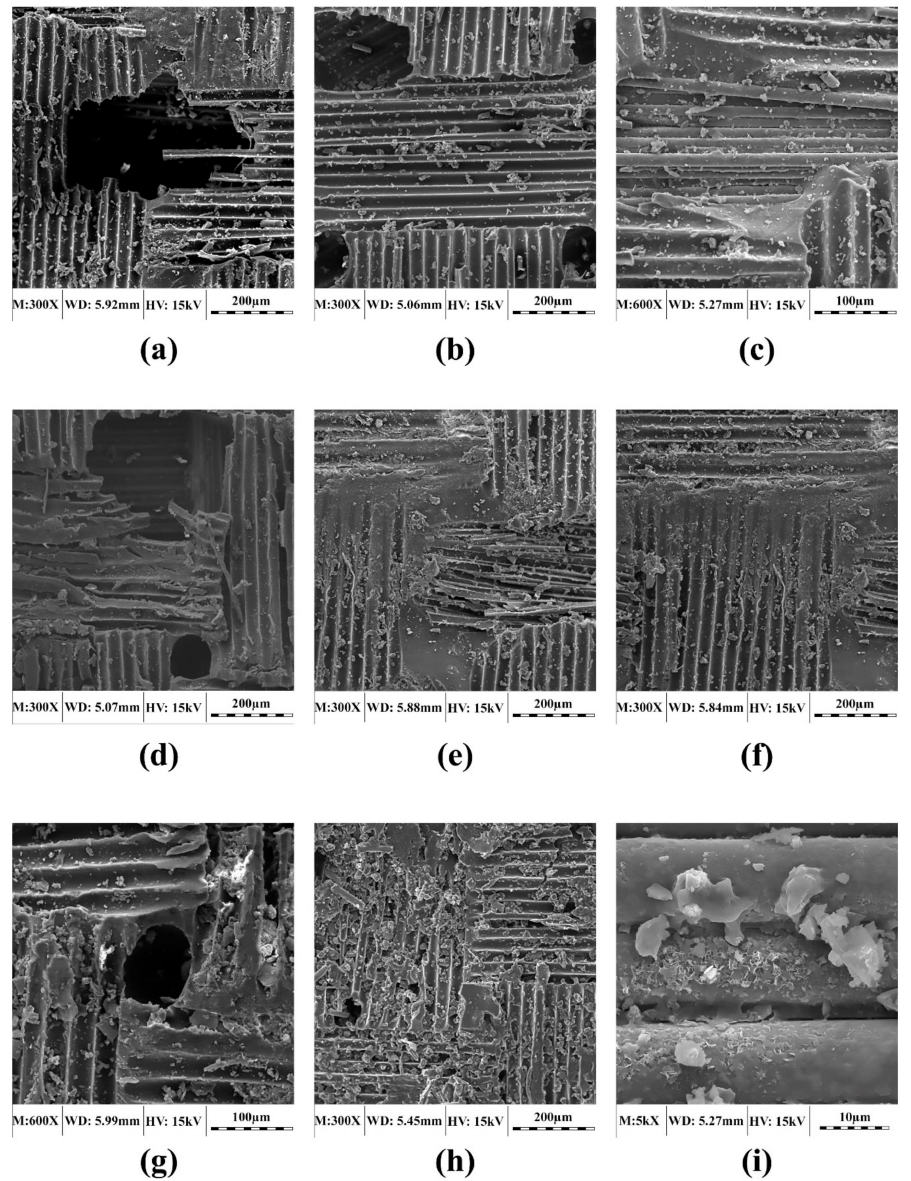
Figure 7. SEM micrographs of selected 2-mm laminates exposed to UV and water vapor condensation cycles: ( a ) UL exposed to 750-h cycles, ( b ) UL exposed to 1250-h cycles, ( c ) UL exposed to 2000-h cycles, ( d ) WL exposed to 750-h cycles, ( e ) WL exposed to 1250-h cycles, ( f ) WL exposed to 2000-h cycles, ( g ) RL exposed to 750-h cycles, ( h ) RL exposed to 1250-h cycles and ( i ) RL exposed to 2000-h